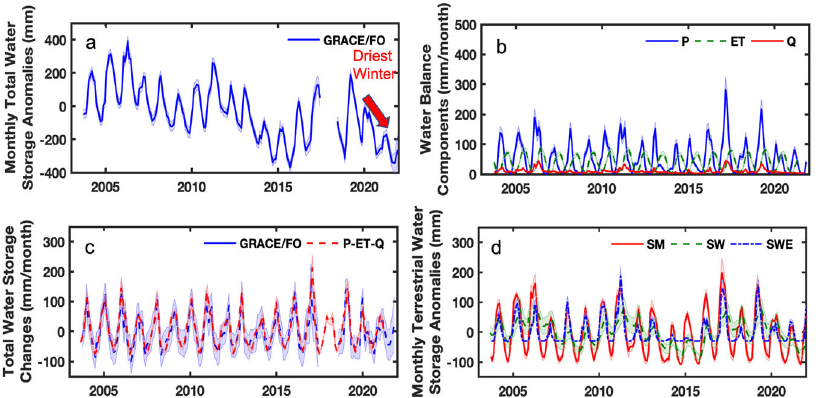
Fig. 2 | Datasets used for groundwater storage anomaly calculation and GRACE/FOdataevaluationintheCentralValley.a GRACE/FOobservedmonthly total water storage (TWS) anomalies. Red arrow indicates the driest winter in TWS for the past two decades at the begining of 2021. b Three water balance fl uxes of precipitation (P), evapotranspiration (ET), and stream fl ow (Q). c Comparison of